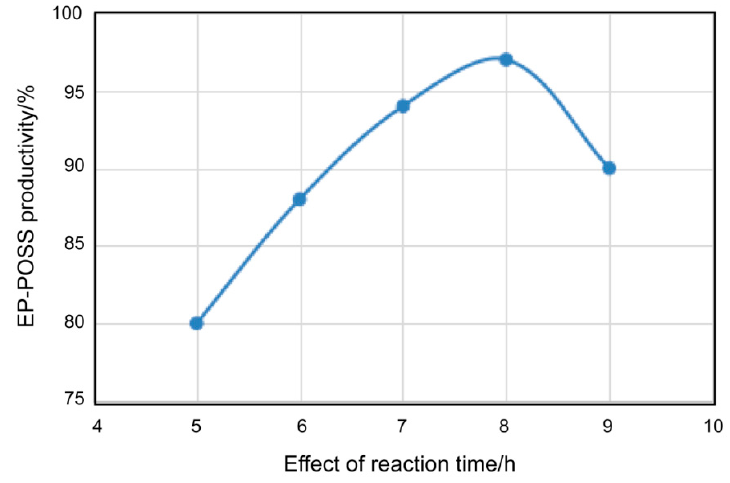
Figure 3. The relationship between heating time and EP-POSS yield.